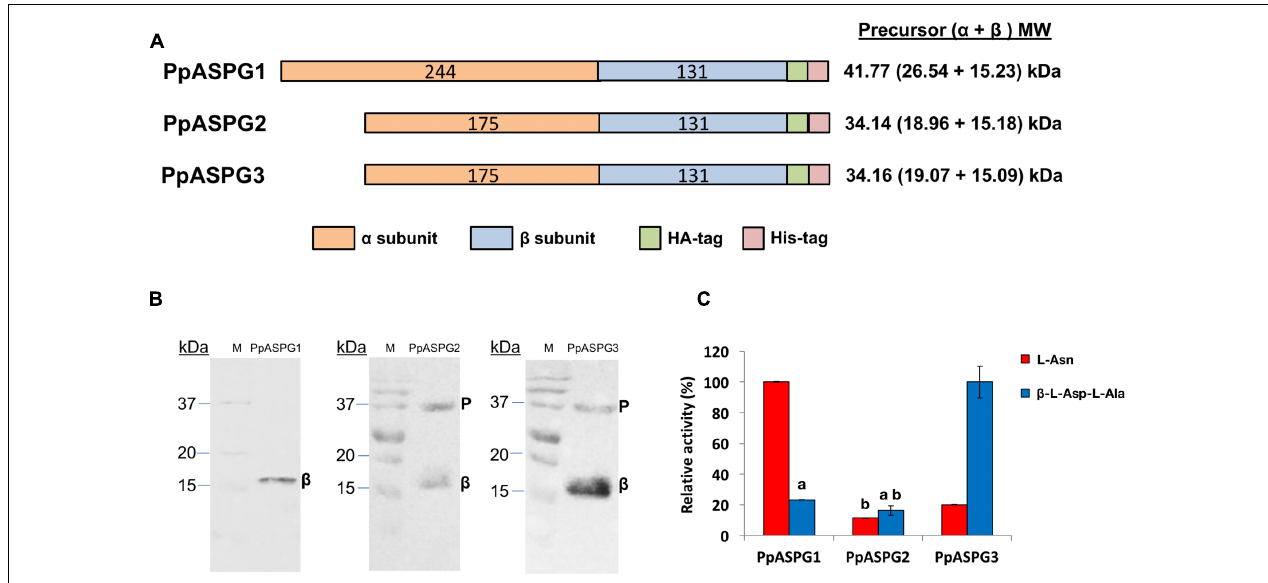
FIGURE 2 | Expression of recombinant pine ASPG in N. benthamiana leaves and substrate preference. (A) Schematic representation of the structure of the three recombinant proteins that were expressed in tobacco leaves via agroinfection. The number of amino acids is included in the colored bars and the theoretical molecular mass corresponding to the precursor and subunits that would result from correct cleavage is indicated on the right. (B) Western blot analysis of tobacco leaf extracts expressing the recombinant proteins. Total soluble proteins (50 µ g) from each leaf extract were separately analyzed by western blot with an antibody against the HA-tag. Bands marked with β correspond to molecular mass of the β subunit including the HA and His tags. Remaining uncleaved precursor (P) is visible in the PpASPG2 and PpASPG3 protein extracts. (C) Recombinant proteins were purified from the protein extracts and their relative activity was determined for two different substrates. For each substrate, catalytic activity is presented as the percentage of the highest specific activity measured at a substrate concentration of 25 mM. Values are the means of three independent replicates ± SD. Values labeled with the same letter are not significantly different according to t -tests ( p < 0.01). The remainder values are significantly